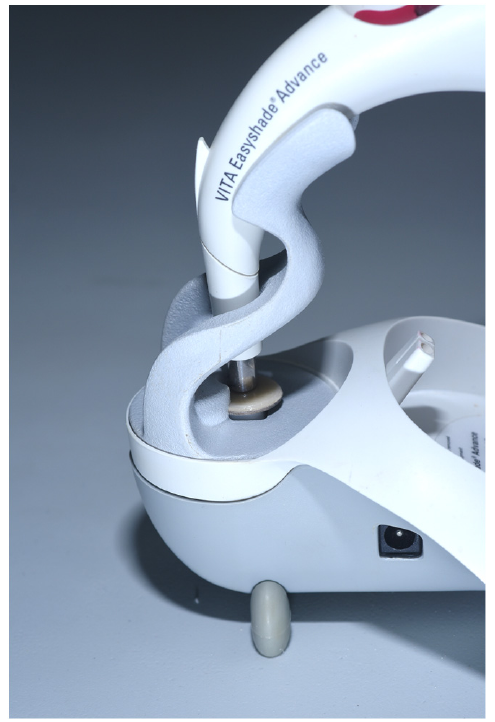
Figure 2. The clinical spectrophotometer VITA Easyshade fixed on a stand for color measurement.